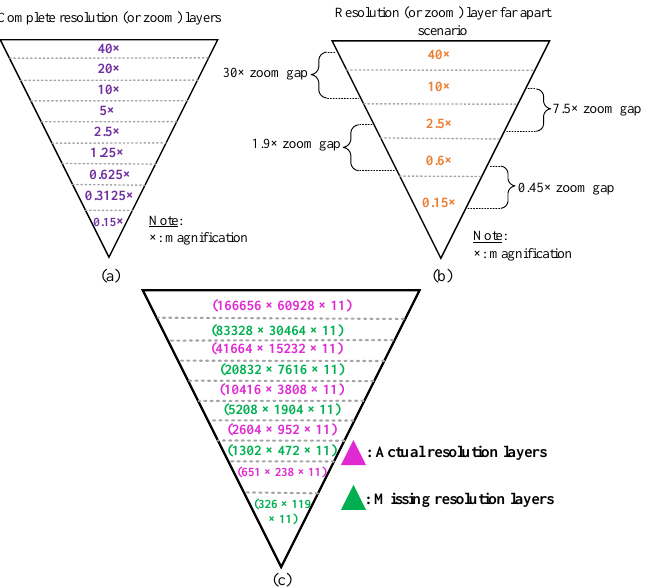
Figure 6. WSI image series of resolution layers; ( a ) complete resolution layers; ( b ) some missing resolution layers; ( c ) actual and found missing resolution layers after applying function-1 and function-2 for the .ndpi sample.